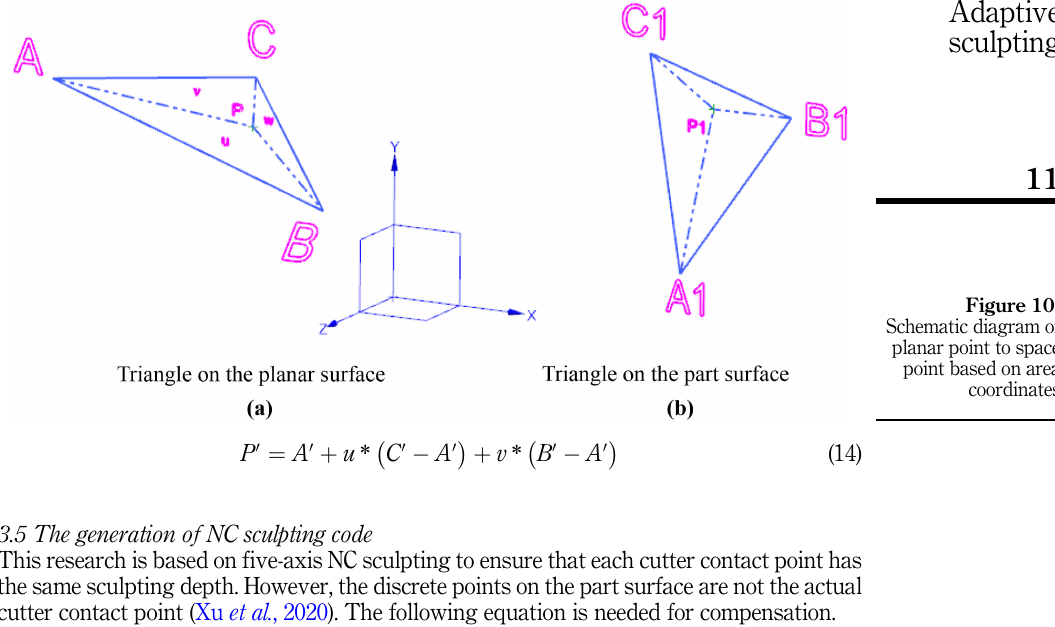
Figure 10. Schematic diagram of planar point to space point based on area